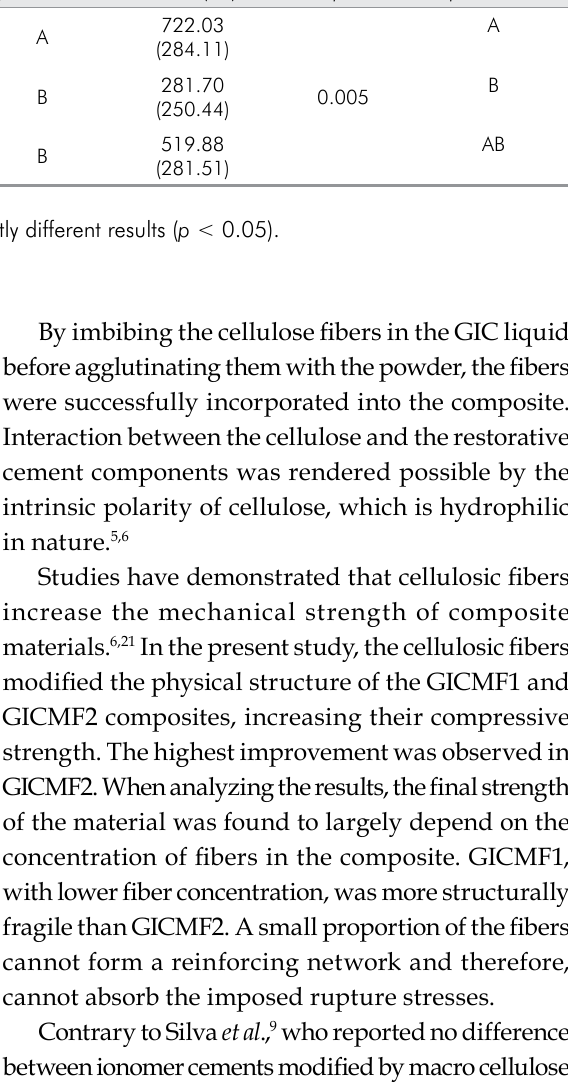
Table 2. Mean and standard deviation values of the diametral tensile strength and stiffness, and their statistical significances. Composite